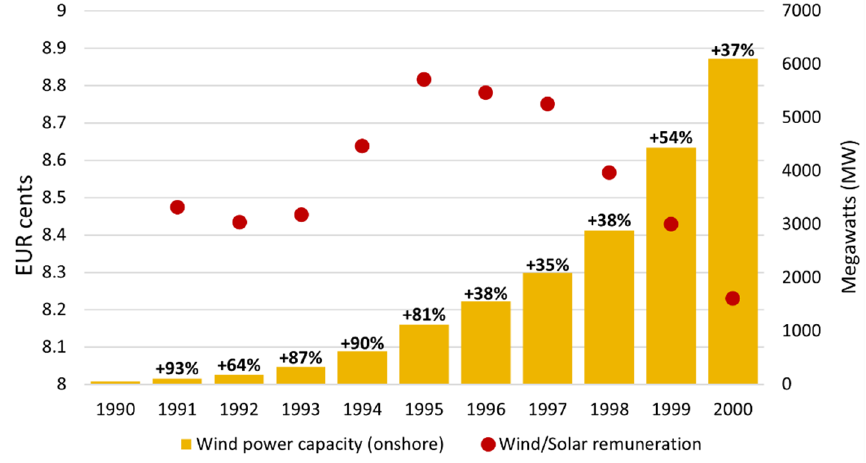
Figure 2. StrEG remuneration levels for wind and solar power (set at 90% of the average electricity price) along with the annual growth rate for onshore wind power capacity. Source: Own elaboration. Data from [24,97,112].